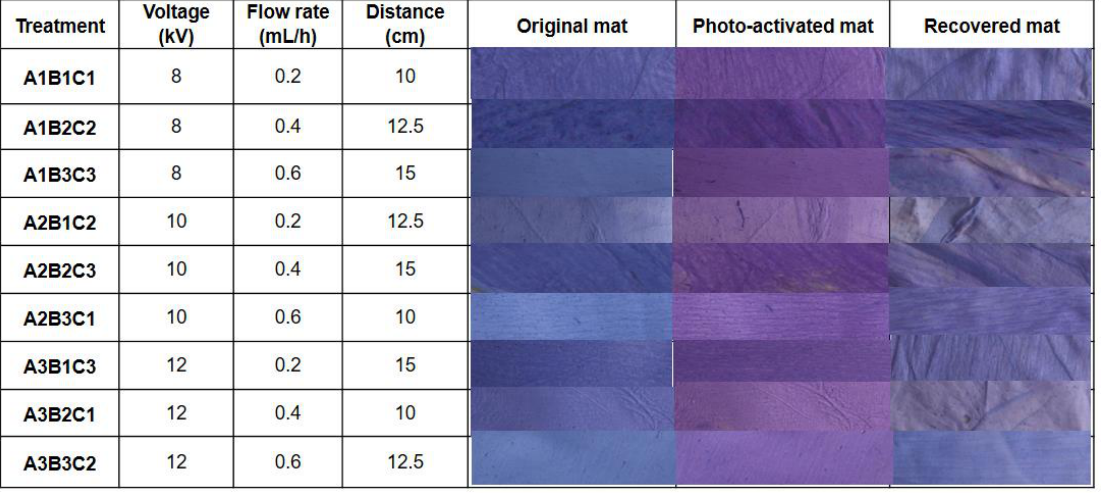
Figure 1. Experimental design for the selected factors with their levels and the visual appearance of the electrospun tags as affected by UV-light treatment and later exposure to ambient air.